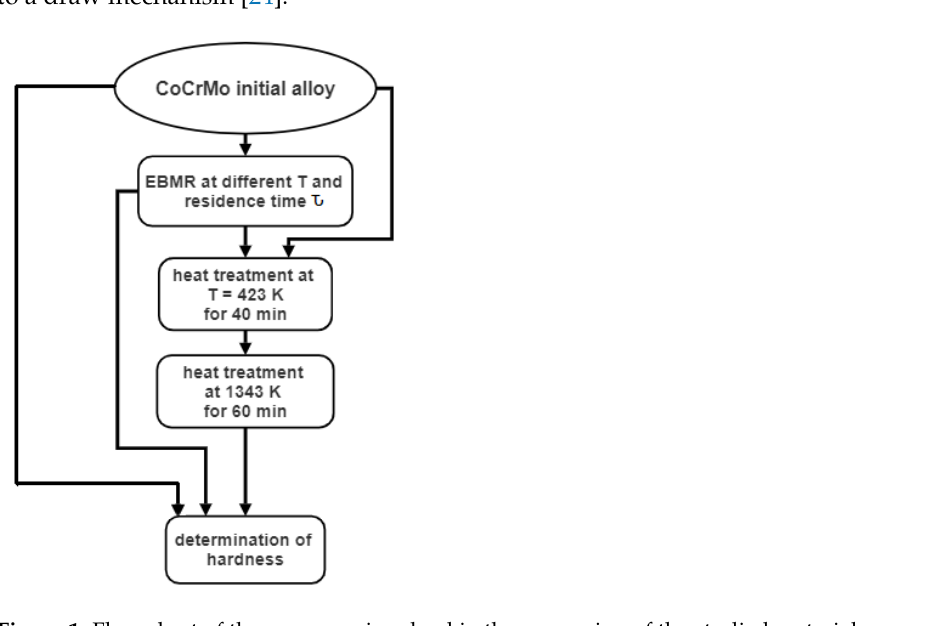
Figure 1. Flow chart of the processes involved in the processing of the studied material.